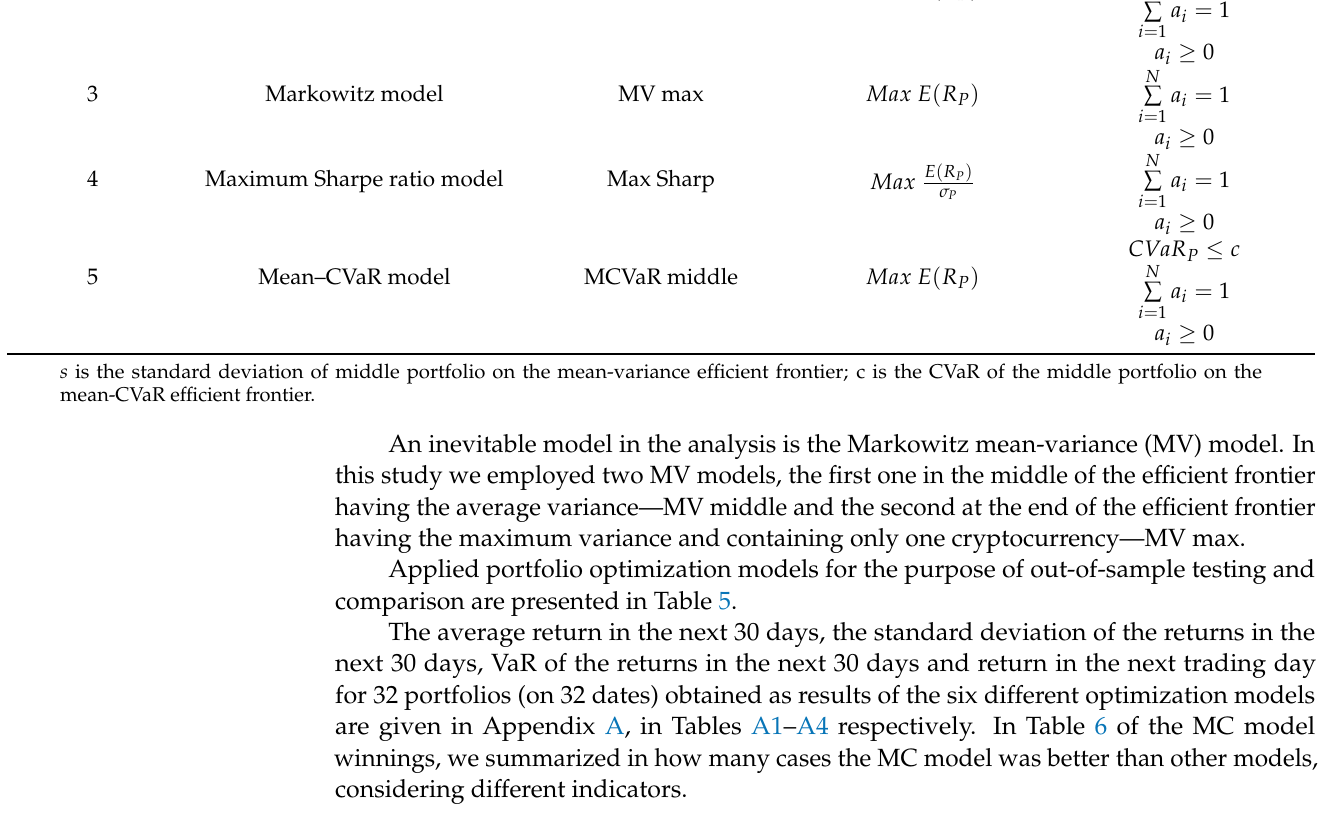
Table 6. MC model